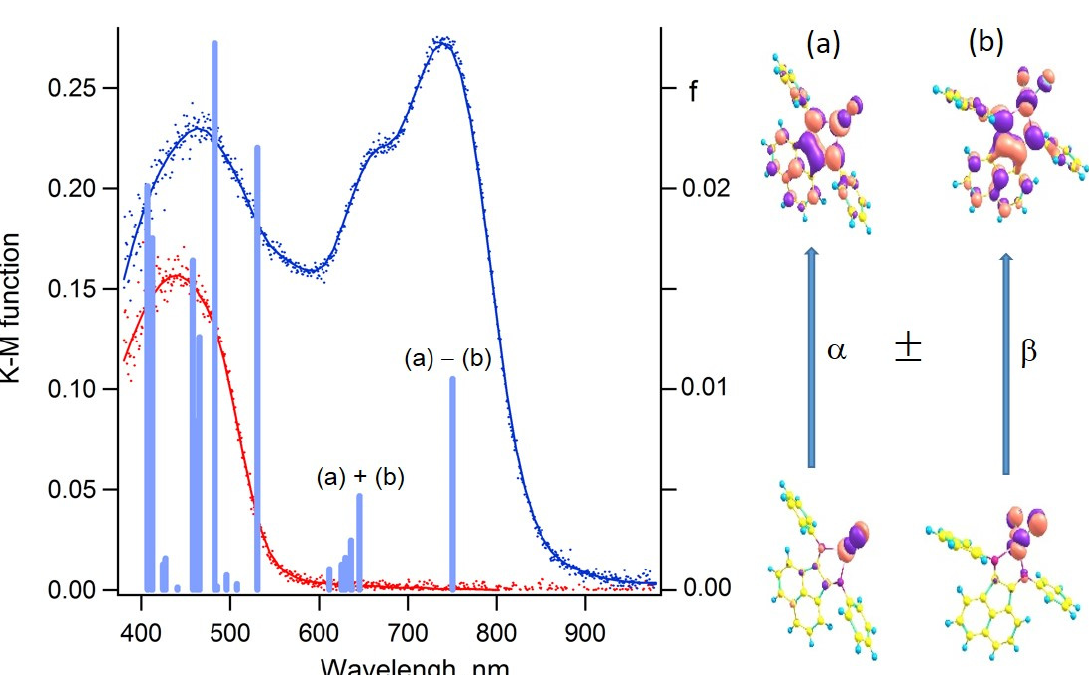
Figure 2. ( Left ) Solid-state electronic absorption spectra in the form of Kubelka–Munk function of dpp-BIAN (red spectrum) and its complex with FeI 2 (blue spectrum); vertical blue bars indicate the positions and oscillator strengths (f, right axis) of the electronic transitions calculated at the B2PLYP/def2-TZVP level for complex [(dpp-BIAN)FeI 2 ]. ( Right ) The electron promotions (( a , b )), which contribute mainly to the intense transitions at 751 ((a) − (b)) and 646 ((a) + (b))